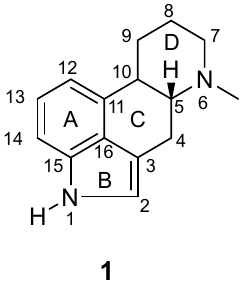
Figure 1. Structure of ergoline ( 1 ).